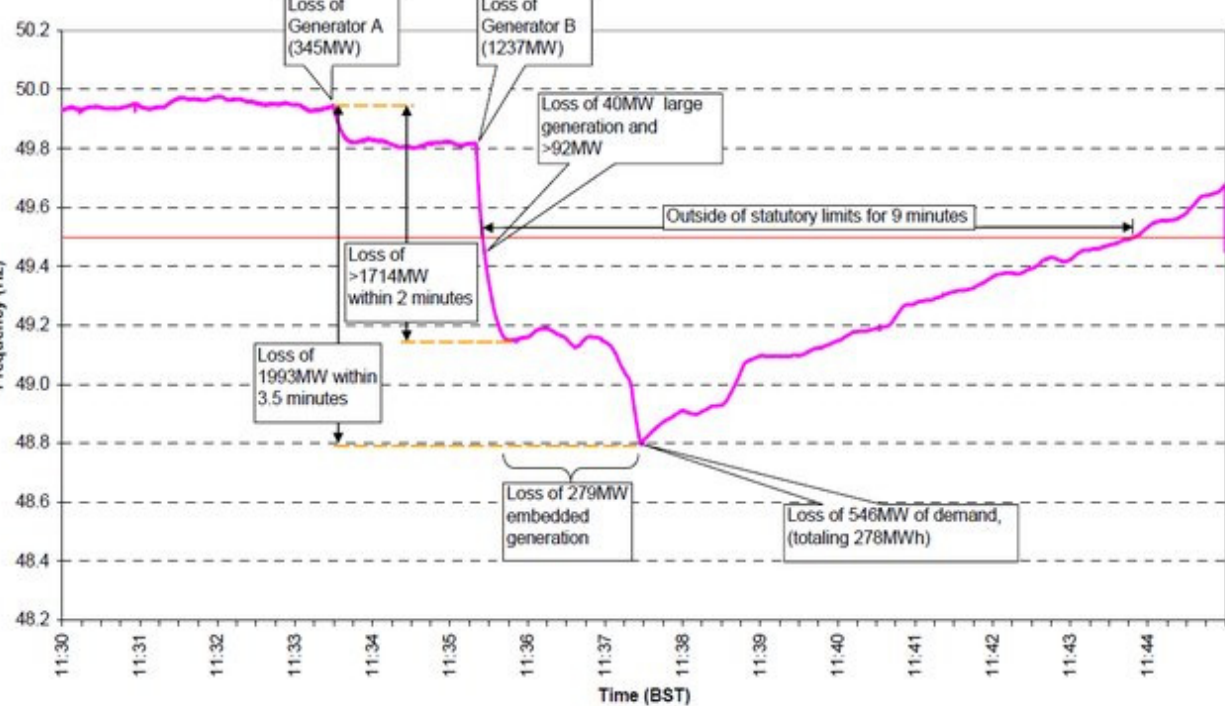
Figure 4. Frequency fluctuation in the Great Britain power system during the failure of the Sizewell B nuclear power plant on 28 May 2008 [65].